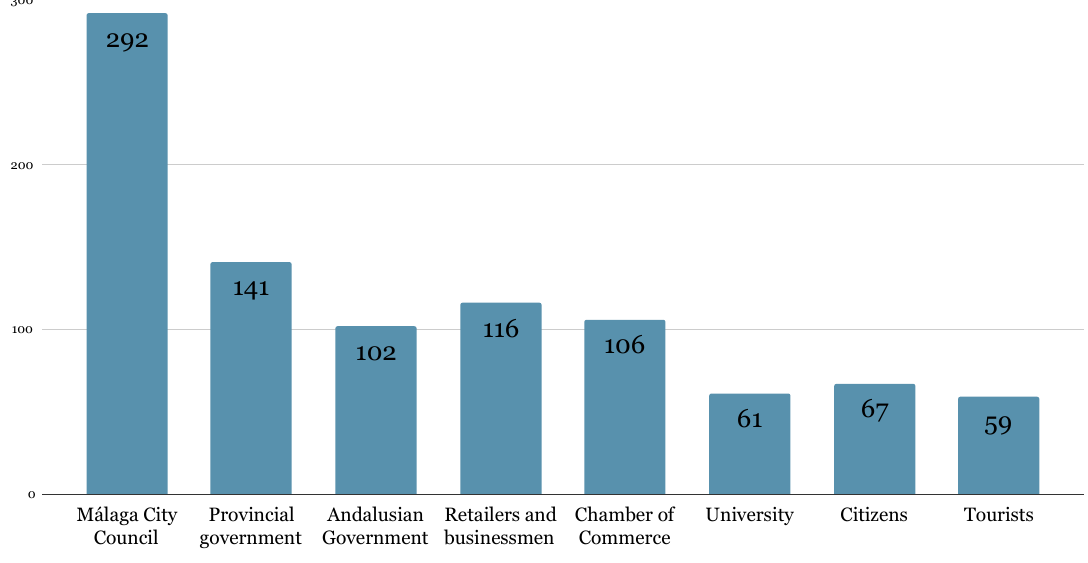
Figure 9. Who should lead the building of the Málaga brand? Source: own elaboration.